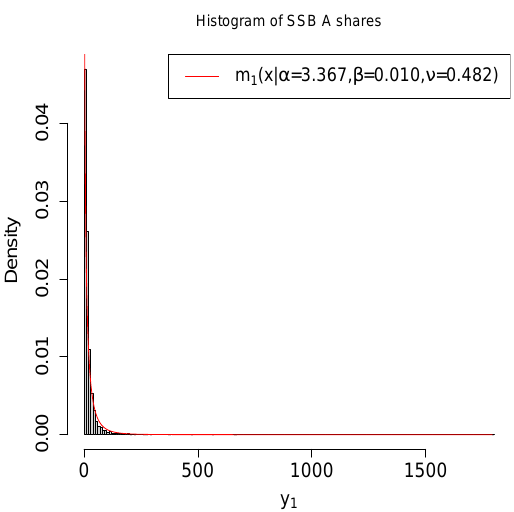
Figure 11. The histogram of the original data x with a fit marginal density m 1 ( x | α = 3.367, β = 0.010, ν = 0.482 )